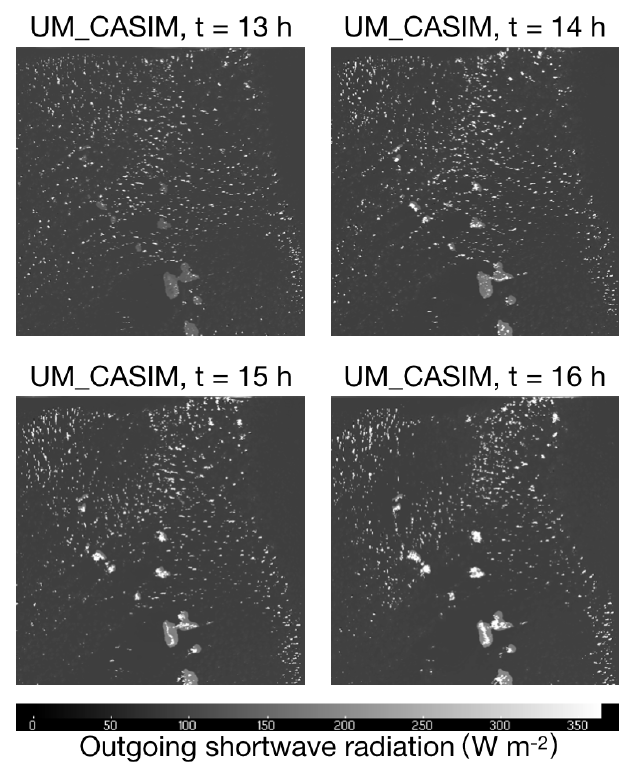
Figure 4. Snapshots of outgoing shortwave radiation showing the structure of the cloud field in the afternoon of the first day of the UM_CASIM